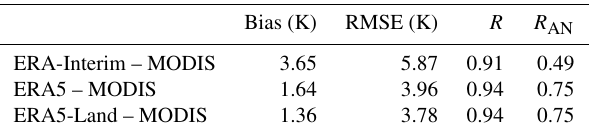
Table 5. Spatially and temporally averaged bias, RMSE, R , and anomaly correlation coefficient ( R AN ) between ERA-Interim, ERA5, and ERA5-Land estimates and the MODIS land surface tem- perature average ensemble for the time period